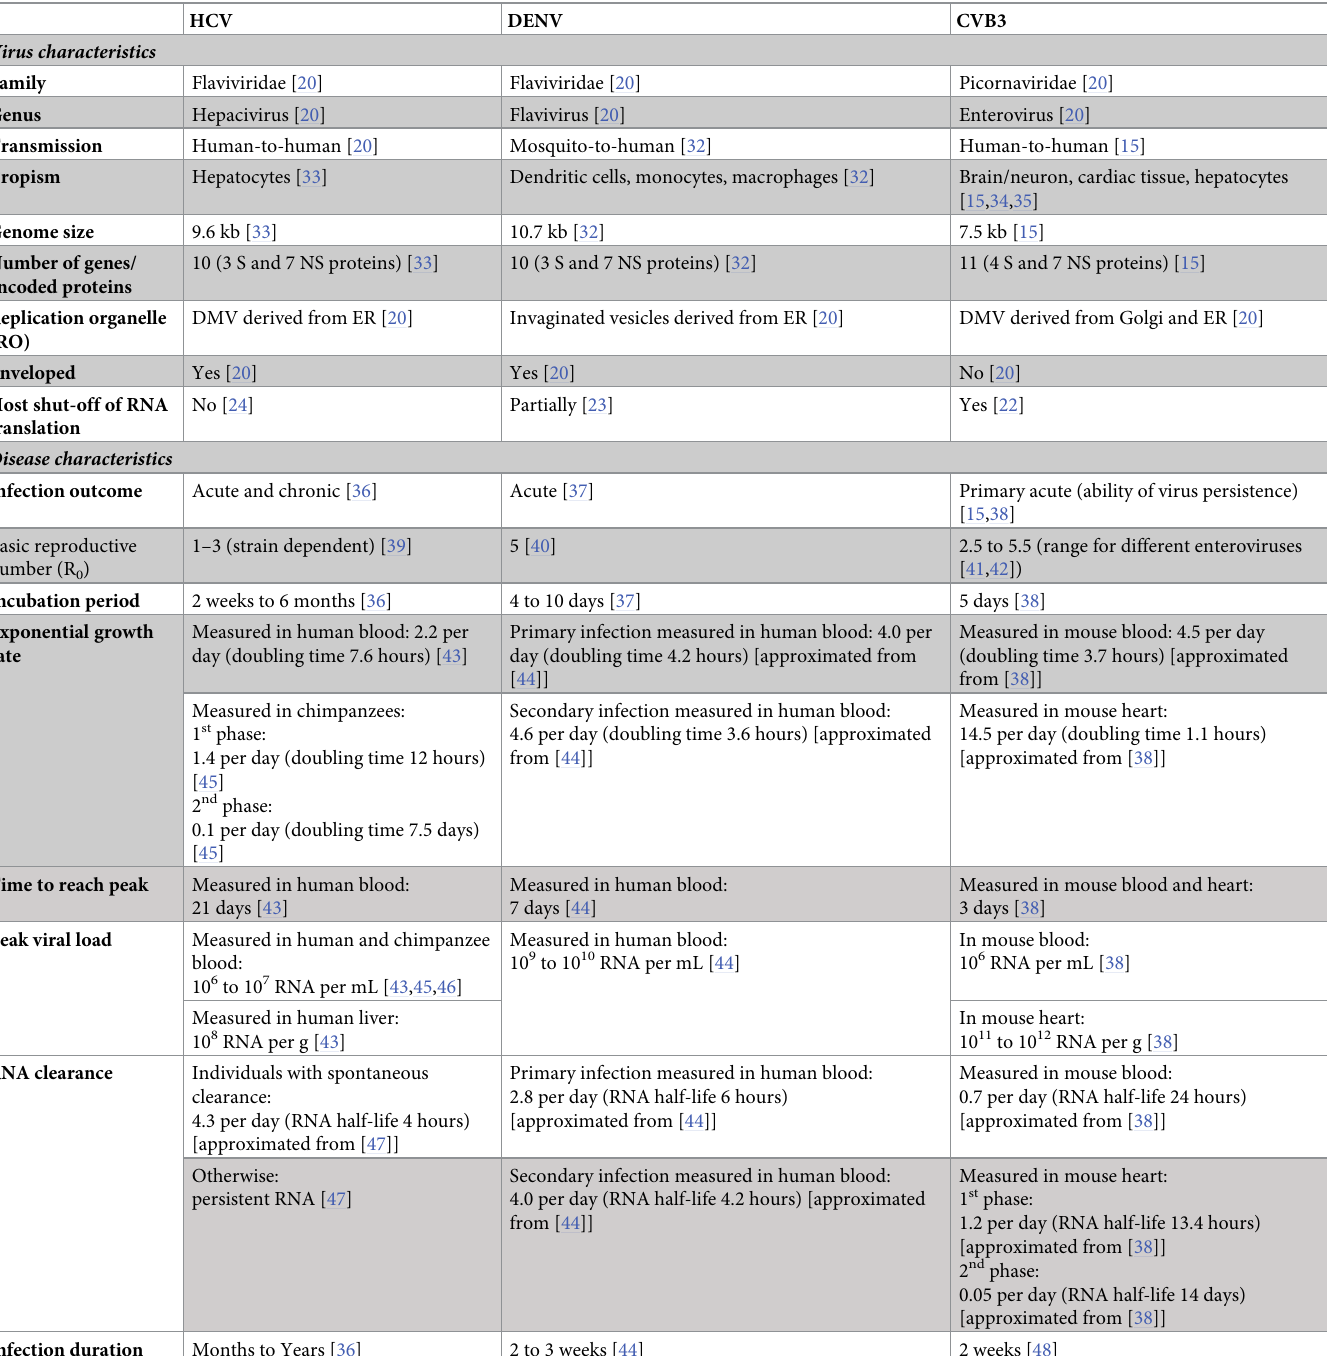
Table 1. Feature comparison of plus-strand RNA viruses. DMV: double-membrane vesicles, ER: endoplasmic reticulum, NS: non-structural, S: structural. HCV